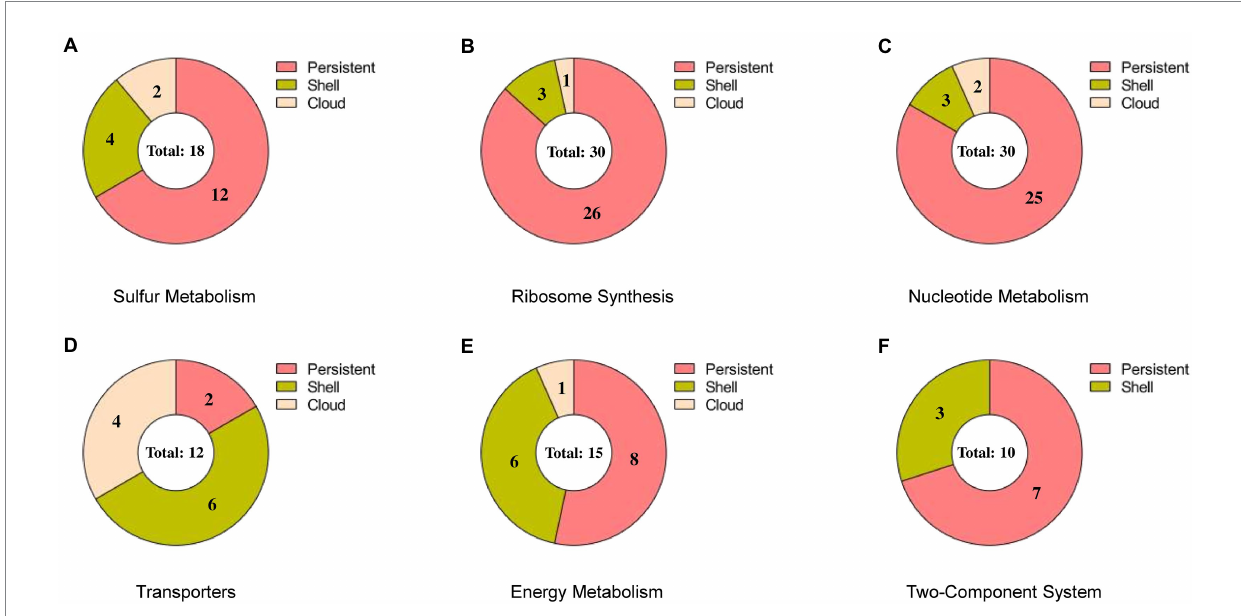
FIGURE 7 Pie chart representing the subgroups of a pan-genome (persistent, shell, and cloud). Each chart represents the sub-categorized genes in (A) sulfur metabolism, (B) ribosome synthesis, (C) nucleotide metabolism, (D) transporters, (E) energy metabolism, and (F) two-component